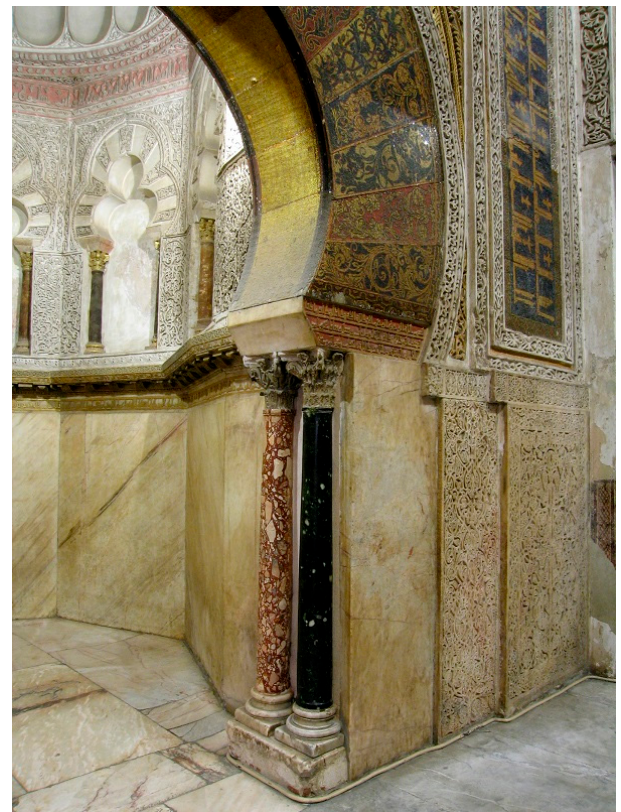
Figure 3. Mihrab of the caliphal phase of the Great Mosque of Cordoba with the columns of ‘Abd al-Ra ḥ m ā n II. © Photo took by author.